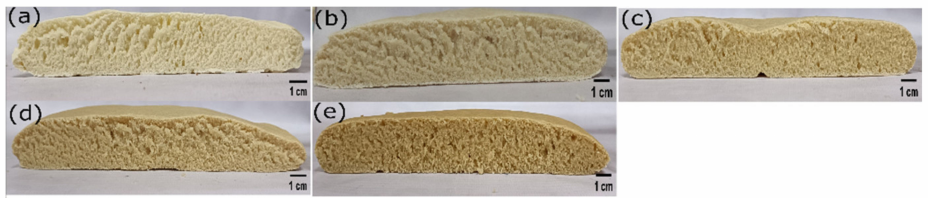
Figure 2. The cross view of different samples. ( a ) WF0, ( b ) WF25, ( c ) WF50, ( d ) WF75, and ( e ) WF100 (Scale bar 1